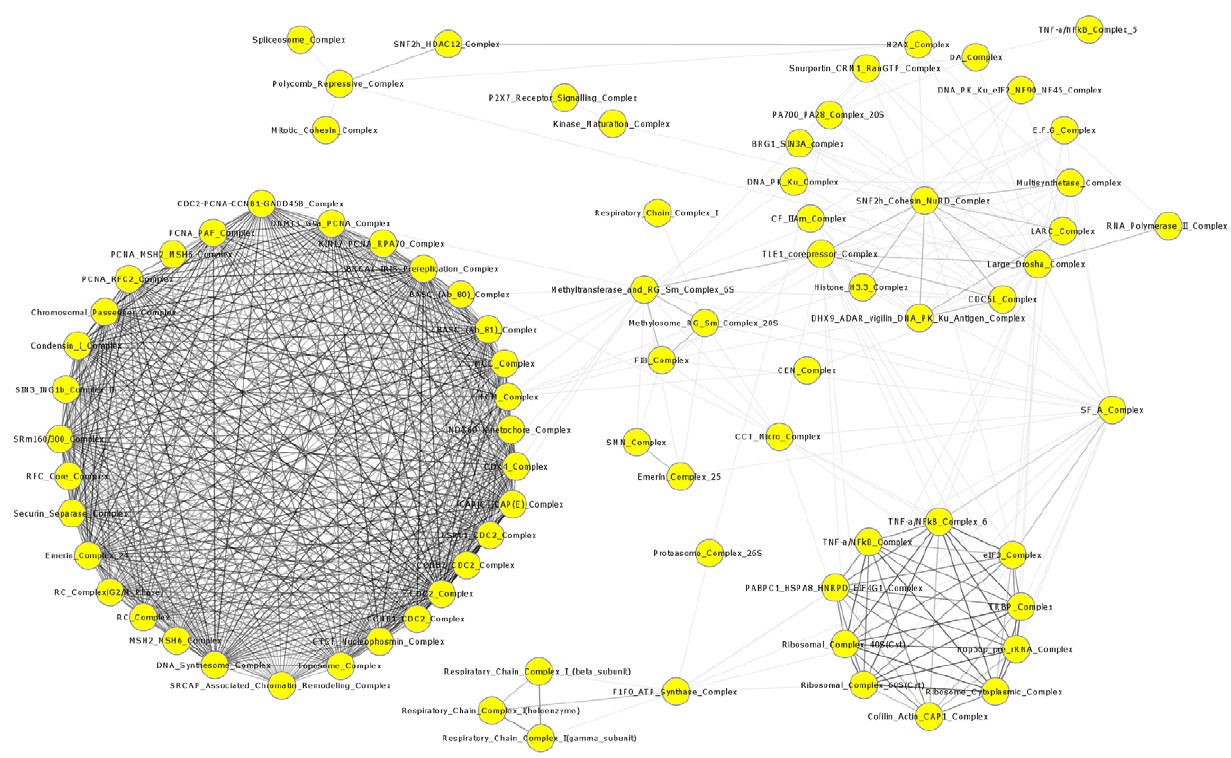
Figure 8. The protein complex cooperativity network. Nodes represent protein complexes, and edges represent high ( w 0 : 7 ) second-order correlation between pairs. The second-order correlation quantifies the cooperativity of activities of the two RHSs modules across different datasets. The darker the color of the edges, the stronger the second-order correlation.